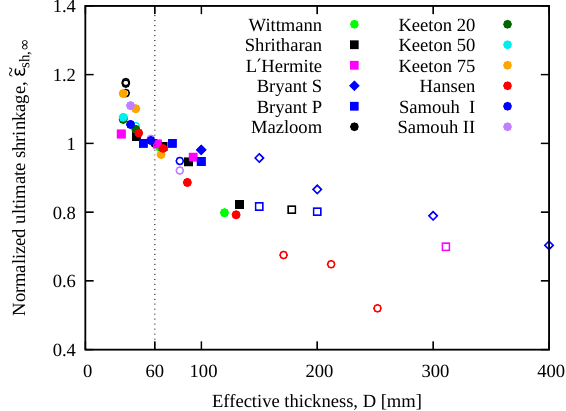
Figure 4. Influence of the effective thickness on the normalized experimentally measured ultimate shrink- age strain. The strain is normalized with respect to the value corresponding to D = 60 mm, empty symbols mark the last data points in prematurely terminated